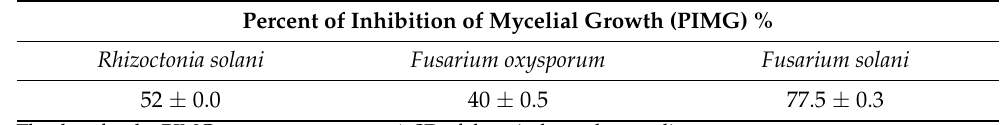
Table 2. P. chysogenum MZ945518 ethyl acetate extract’ antifungal